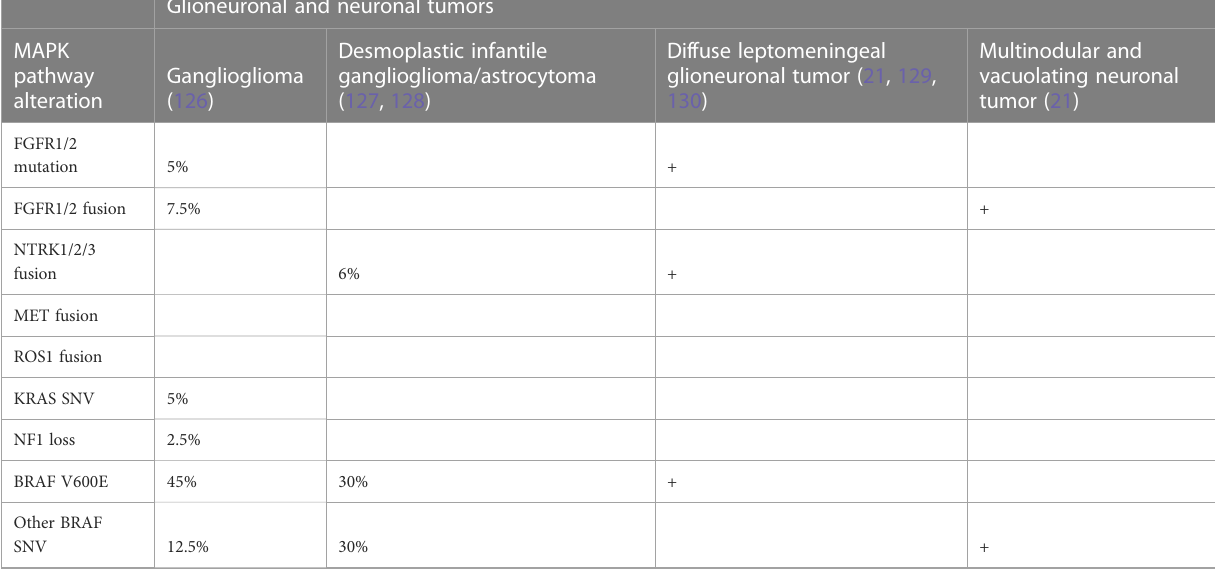
TABLE 1B MAPK pathway alterations by tumor type